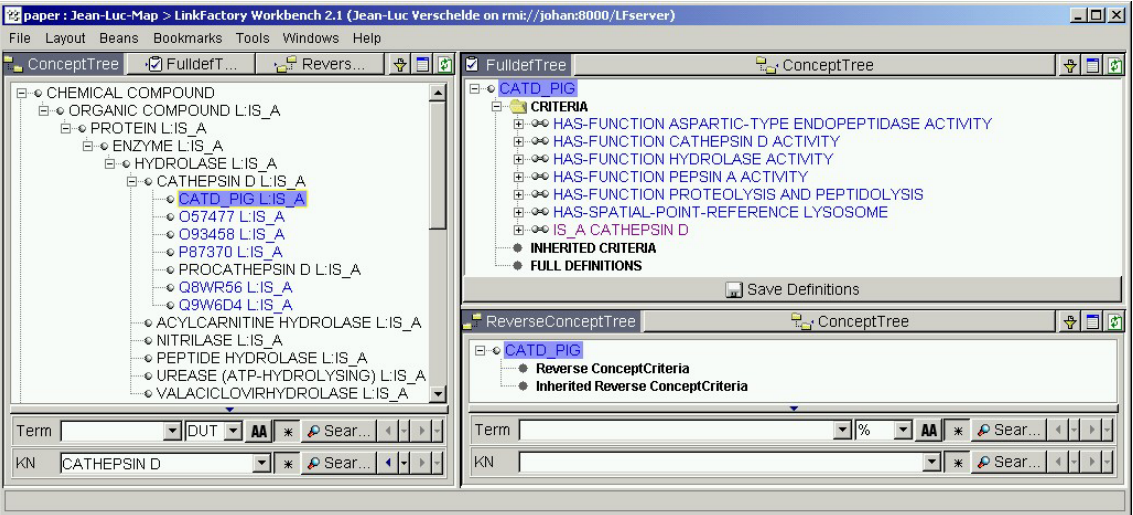
Figure 3 Cathepsin D from pig (<CATD_PIG>) is associated with different functions and is spatially related to the lysosome. <CATD_PIG> is an aspartic protease (has-function 'aspartic, type endopeptides activity') and is actively present in the lysosome (has-spatial-point-reference